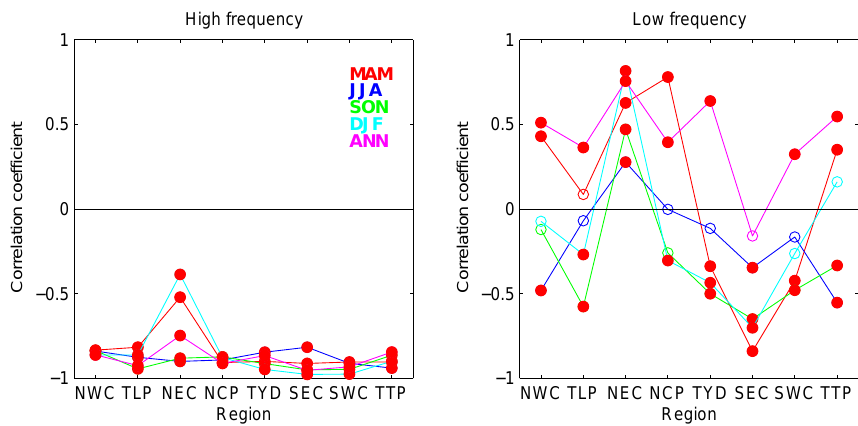
Fig. 4. Correlation coefficients of high (left) and low (right) frequency between diurnal temperature range and total cloud cover.